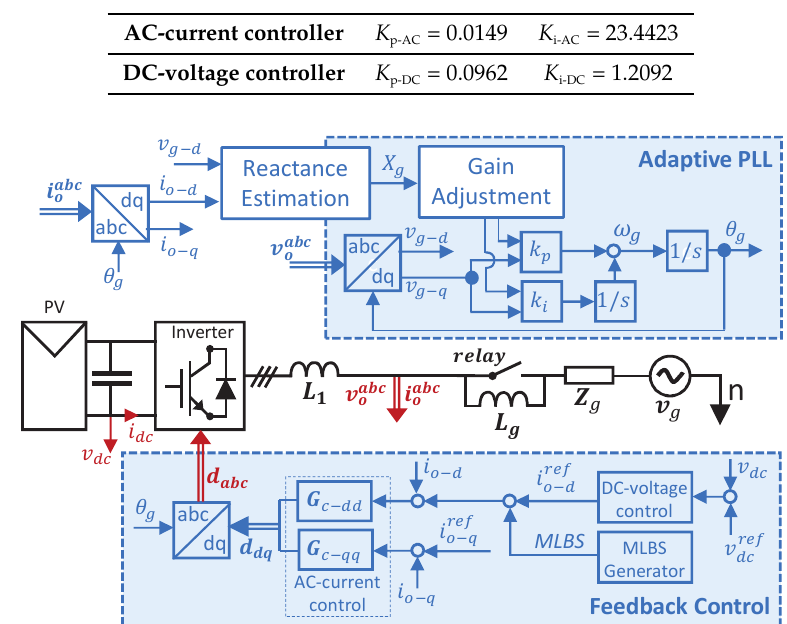
Figure 8. Three-phase inverter with adaptive synchronous-reference-frame PLL